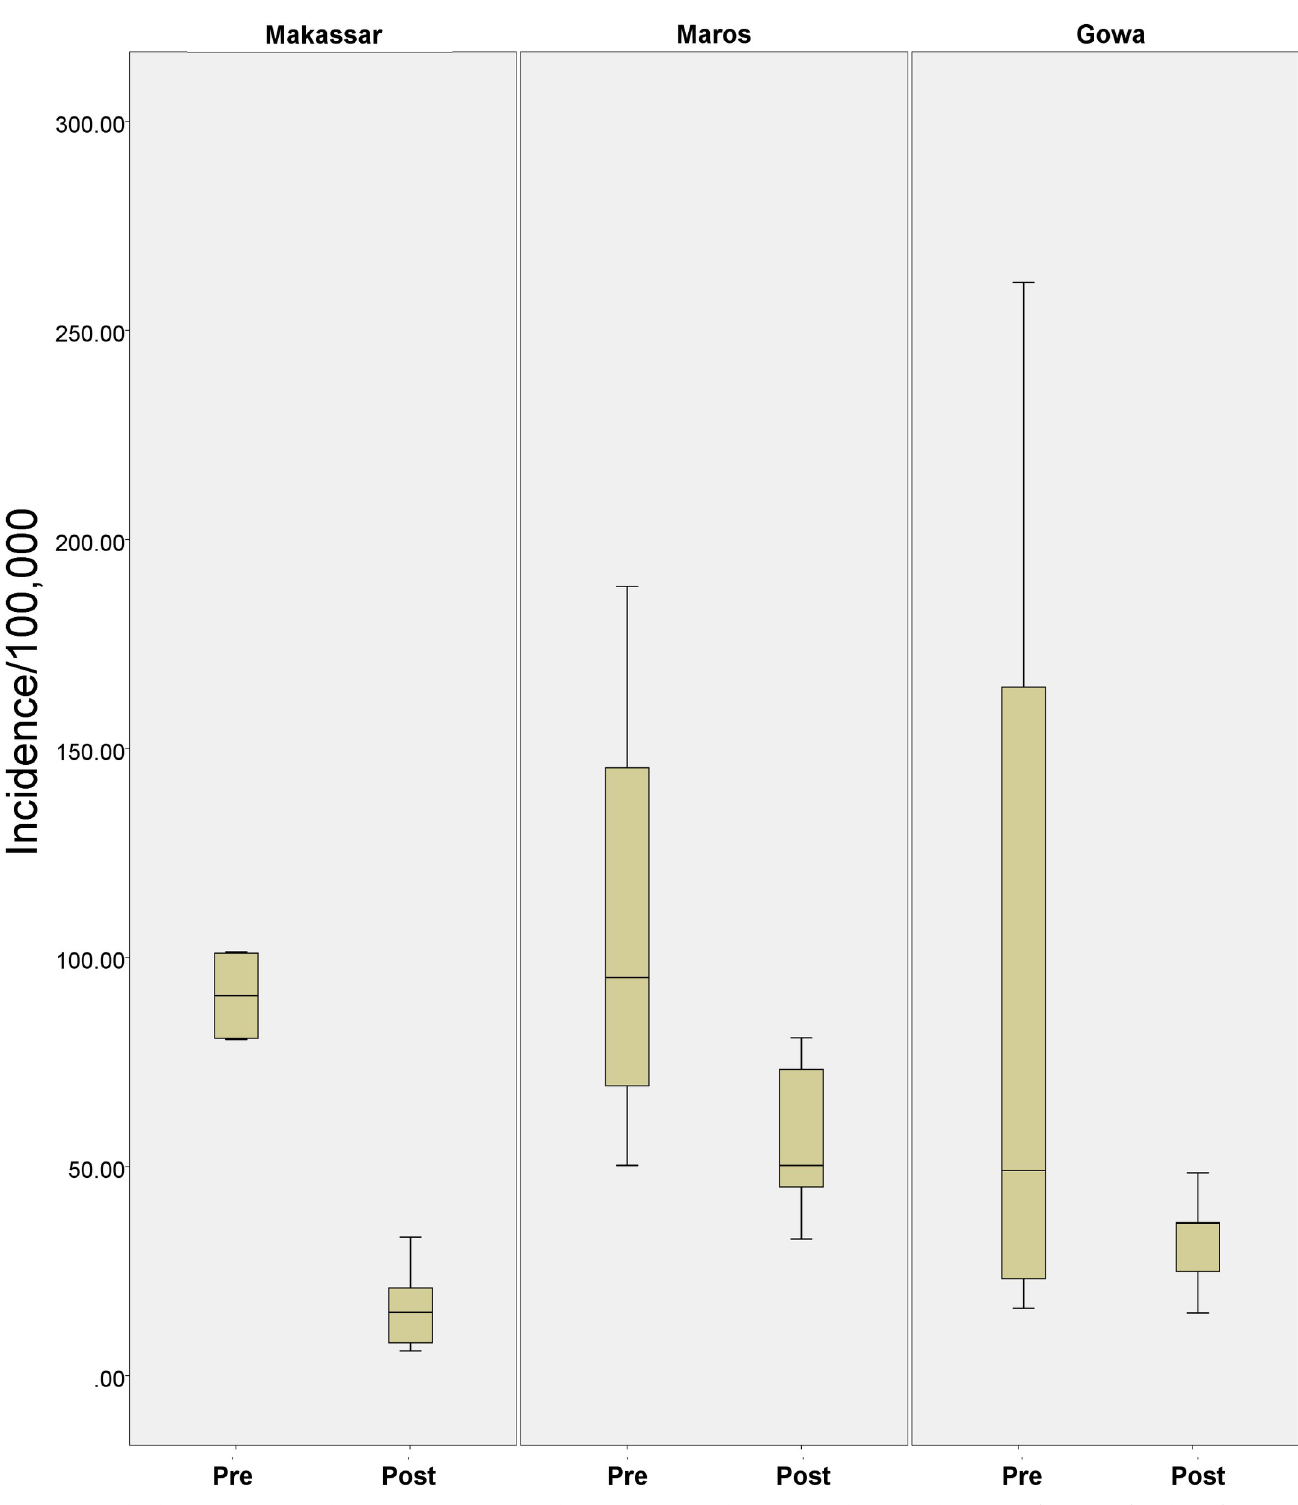
Fig 2. A Box-plot demonstrating the differences in incidence in Makassar and the neighboring cities of Maros and Gowa, pre (2003–2006) and post (2007– 2014) intervention. There was a significant reduction in incidence in Makassar pre and post intervention (Mann Whitney U test, p = 0.007), a decrease in Maros (p = 0.042), and a non-significant decrease in Gowa (p = 0.497). Population level data (and hence incidence calculations) were only present from 2003 onwards.